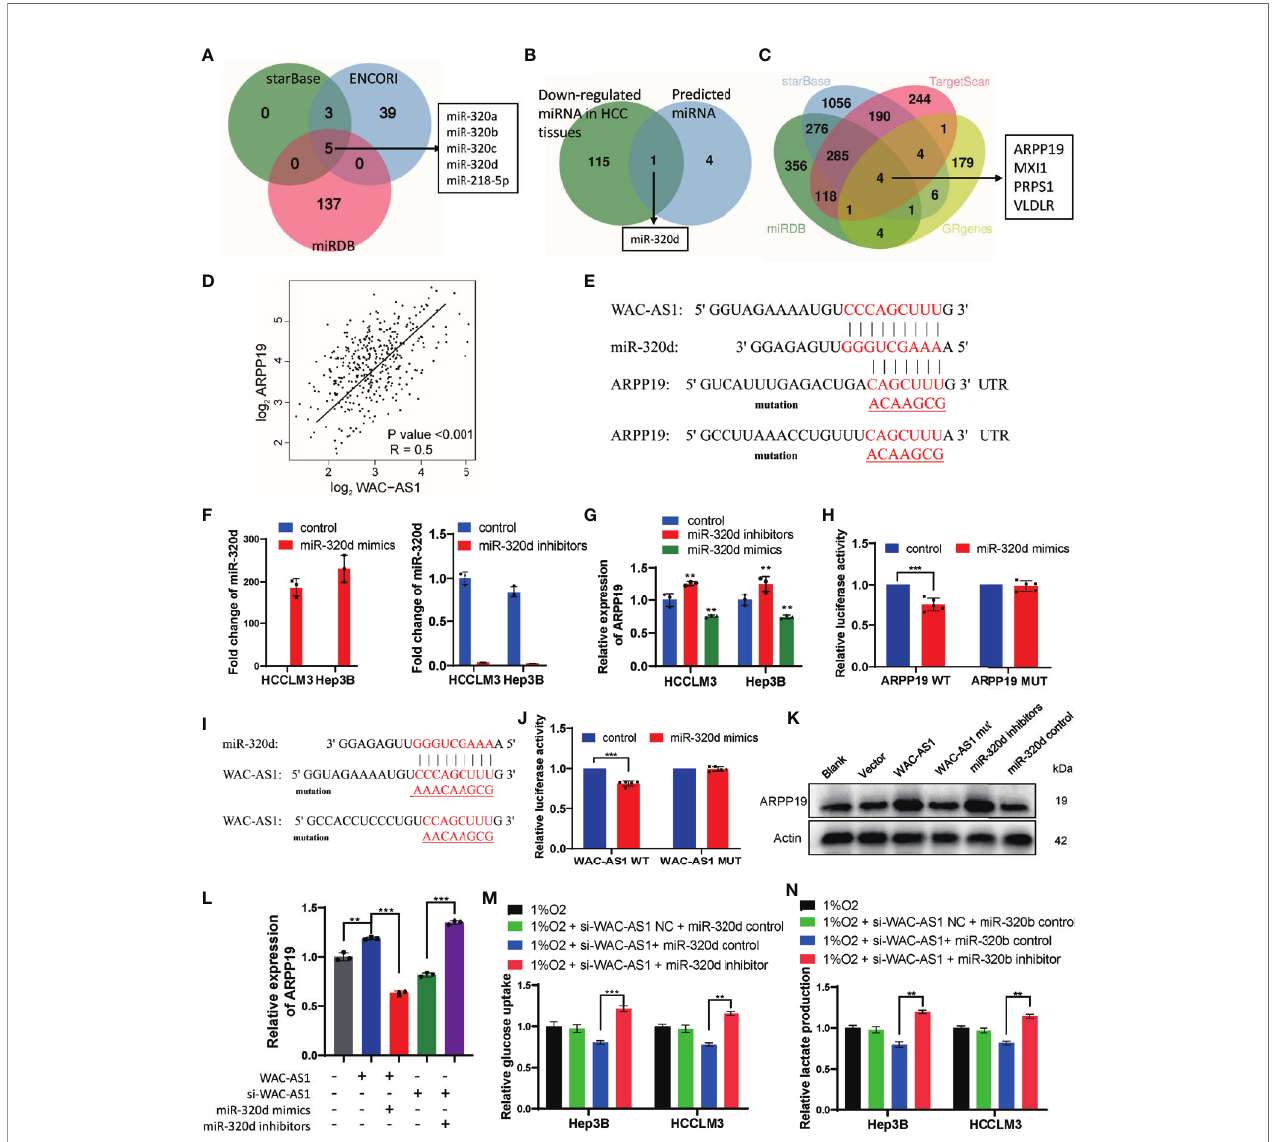
FIGURE 8 | WAC-AS1 regulated ARPP19 by sponging miR-320d. (A) venn diagram showing the predicted target genes of WAC-AS1 from databases (miRDB, ENCORI, and starBase); (B) screening out target genes with differences analysis; (C) venn diagram showing the predicted target genes of miR-320d; (D) the correlation analysis between WAC-AS1 and ARPP19 using data from TCGA database; (E) the wild-type and the mutated sequences of the ARPP19 mRNA 3 ’ -UTR (mutation site: red); (F) the levels of miR-320d after miR-320d mimics and miR-320d inhibitor were transfected; (G) expression of the ARPP19 after treated with miR- 320d mimics or inhibitor; (H) the luciferase activity in luciferase reporter plasmid containing wild-type ARPP19 and mutated ARPP19 co-transfected with miR-320d mimics or negative control; (I) the wild-type and the mutated sequences of the WAC-AS1; (J) the luciferase activity in luciferase reporter plasmid containing wild-type WAC-AS1 and mutated WAC-AS1 co-transfected with miR-320d mimics or negative control; (K) the protein levels of ARPP19 were regulated by WAC-AS1 and miR-320d; (L) ARPP19 expression in differentially treated cells; (M) glucose uptake in Hep3B and HCCLM3 cells; (N) lactate production detected by the lactate assay kit. ∗∗ P < 0.01; ***p <